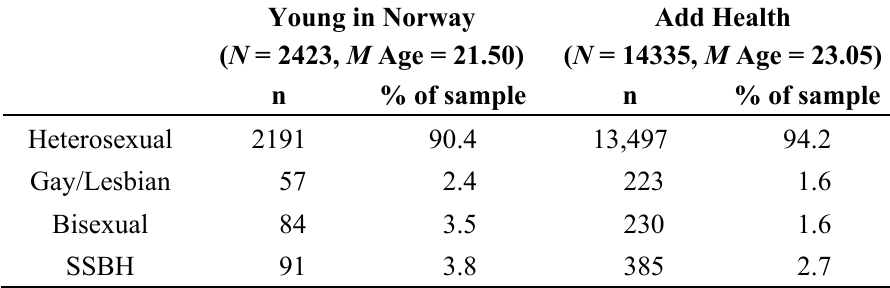
Table 1. Sample characteristics for Young in Norway (1999) and Add Health